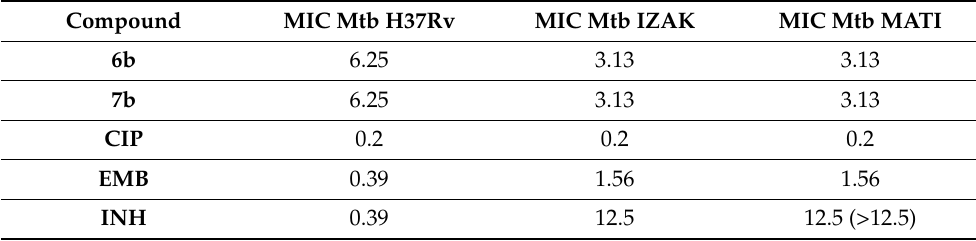
Table 3. Antimycobacterial activity of compounds against Mtb H37Rv virulent strain and MDR clinical isolates. MIC values are in µ